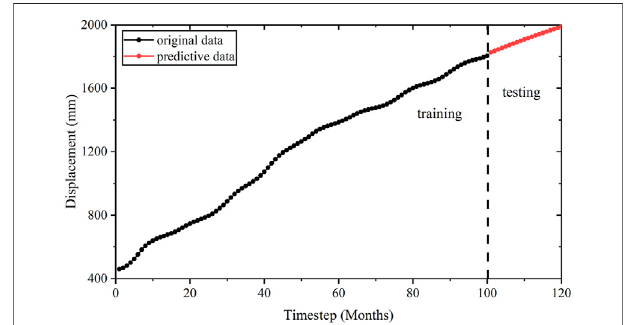
FIGURE 6 | Plot showing the prediction of the trend displacement.